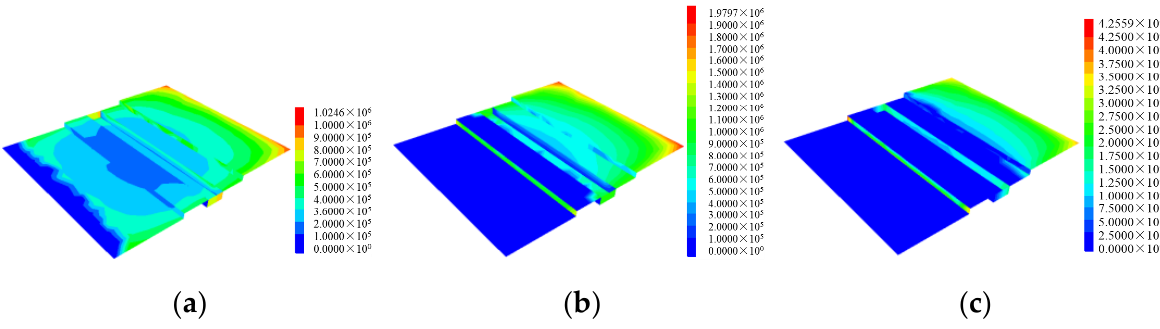
Figure 17. Variation of the contact normal stress on the rock-concrete interface with the increasing lateral thrust. (Unit in Pa). ( a ) 2 × design load (500 kN); ( b ) 3 × design load (750 kN); ( c ) 4 × design load (1000 kN).